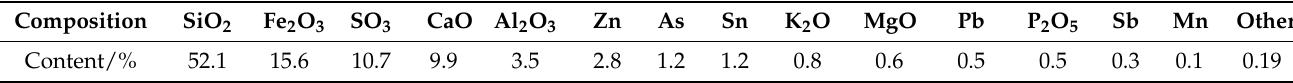
Table 1. The semiquantitative analysis results of the test sample